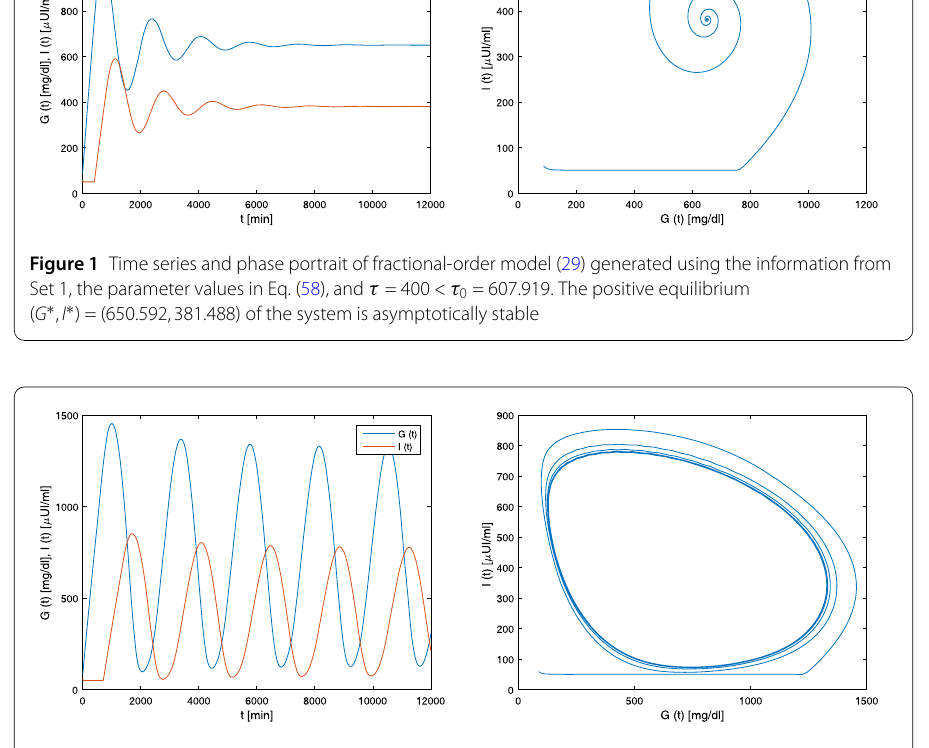
Figure 2 Time series and phase portrait of fractional-order model (29) generated using the information from Set 1, the parameter values in Eq. (58), and τ = 700 > τ 0 = 607.919. A periodic oscillation bifurcates from the equilibrium point ( G ∗ , I ∗ ) =